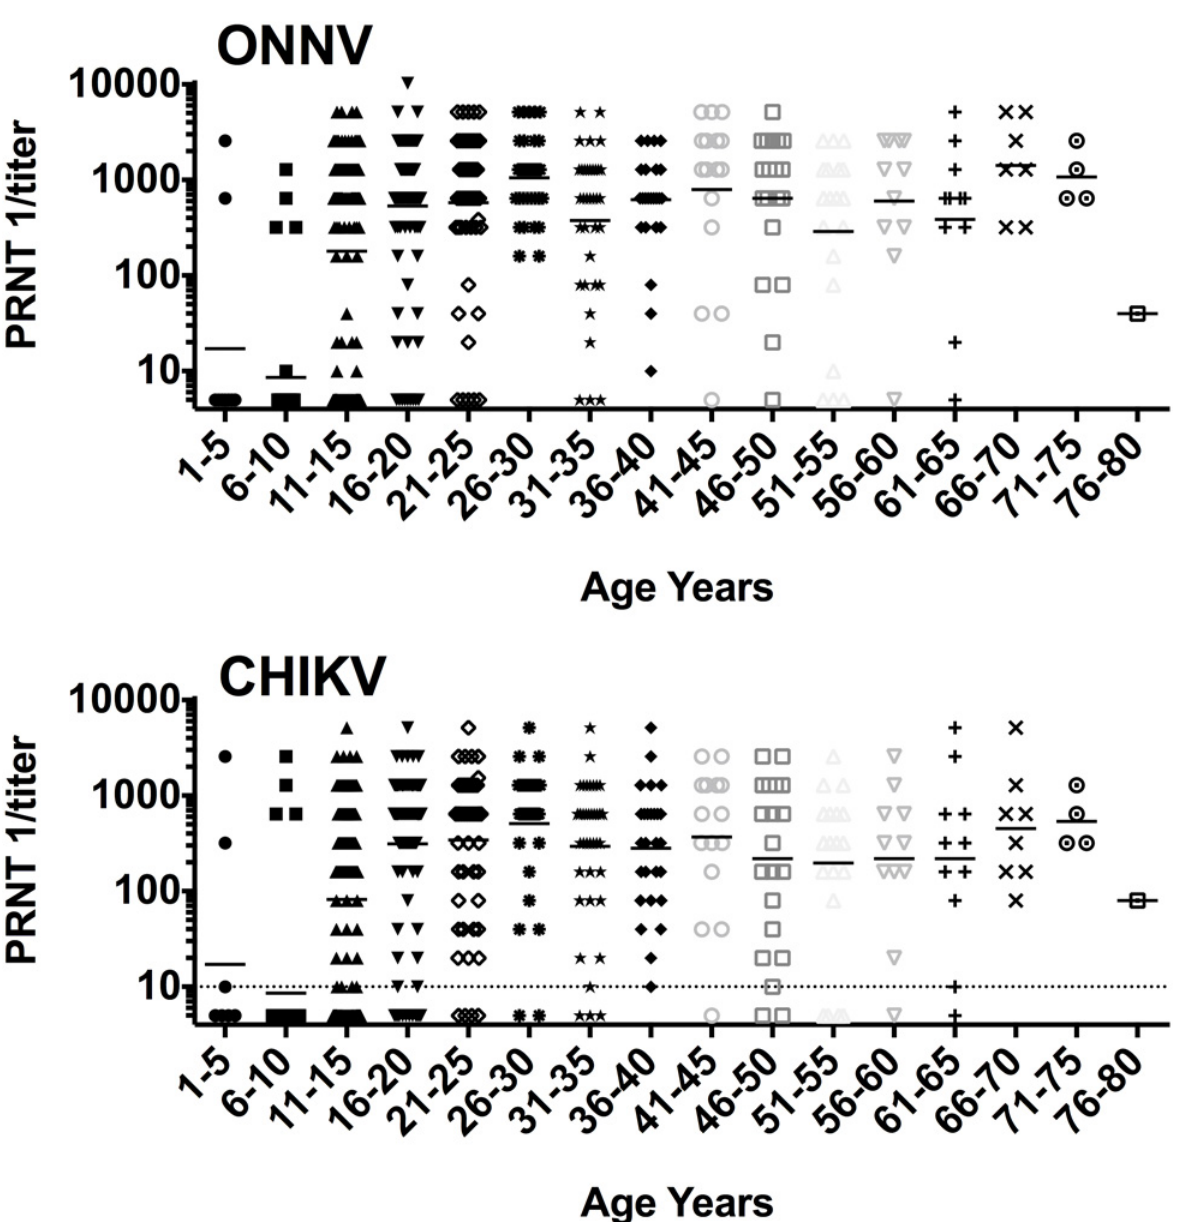
Figure 3. Plaque reduction neutralization titer results by age. ONNV (top) and CHIKV (bottom) titers by 5 year age group. Geometric means indicated by horizontal bars.